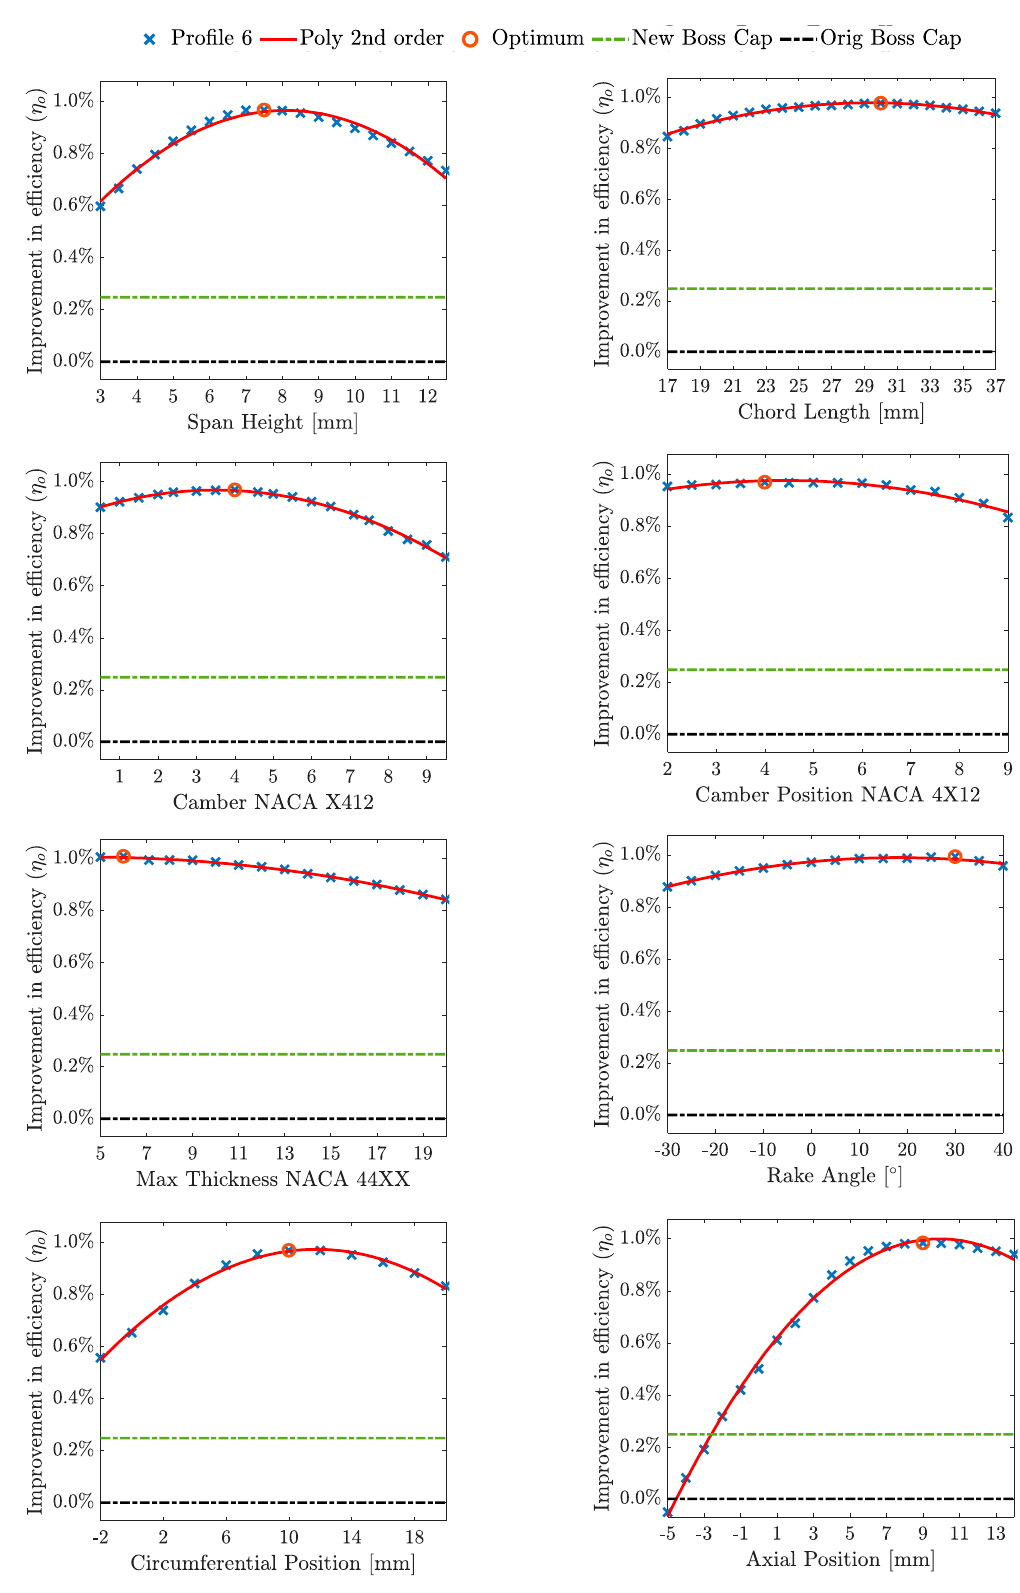
11 of 18 Figure 6. Propeller efficiency increase ( Δ𝜂 (cid:3042) / 𝜂 (cid:3042) ) by implementing different profiles as the PBCFs in the base design: under the same advance ratio and rotational speed (blue bar, on the left in each pair) and under the same thrust (red bar, on the right in each pair). This is in good alignment with the recent study [19], in which four airfoil-based PBCFs were numerically investigated for their impacts on the performance of a model five-blade propeller in open water conditions and NACA4412 airfoil-based PBCFs were found to have the greatest effect on the propeller efficiency. 3.3. CFD-Based Optimum Design of the PBCFs NACA4412 (i.e., profile 6) was finally used in the optimum design of the PBCFs. Be- sides the optimal number of fins ( 𝑛 = 4 ) and installation angle ( 𝛼 = 52° ), the other dimen- sion and installation parameters in Table 5, as well as the shape or profile of NACA4412, were further investigated for their impacts on the performance of the propeller/rudder system. To better understand NACA4412 shape optimization, the terminology of the four- digit NACA airfoils will be briefly introduced. The first digit expresses the maximum camber in percent chord, the second digit defines the location of the maximum camber point in tenths of the chord, and the last two digits gives the maximum thickness in per-